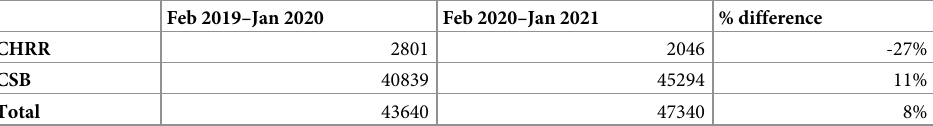
Fig 1. Difference in the number of consultations that took place in CSBs (median) and the CHRR (total number) in Amoron’i Mania from February 2020 to February 2021 compared to the same period the previous year. https://doi.org/10.1371/journal.pntd.0010064.g001 Table 1. Number of consultations taking place in CSBs and at the CHRR before and during the pandemic